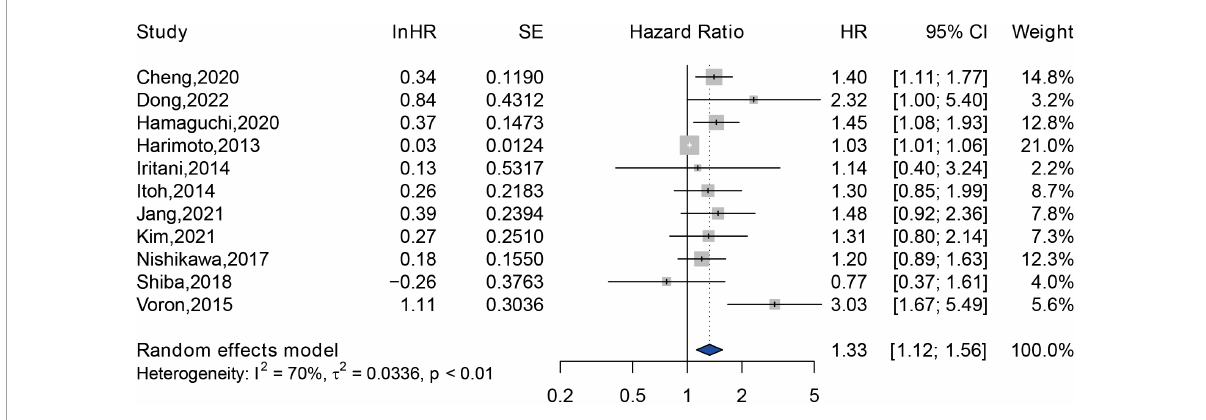
FIGURE4 Forest plot of the pooled hazard ratio for association between sarcopenia and progression free survival in patients with hepatocellular carcinoma.